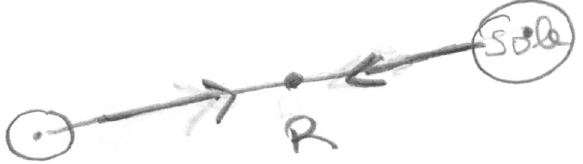
FIG. 8. Sample 2 student ’ s sketch of the forces acting on a star ’ s small volume element. Translation of Italian label: Sun.